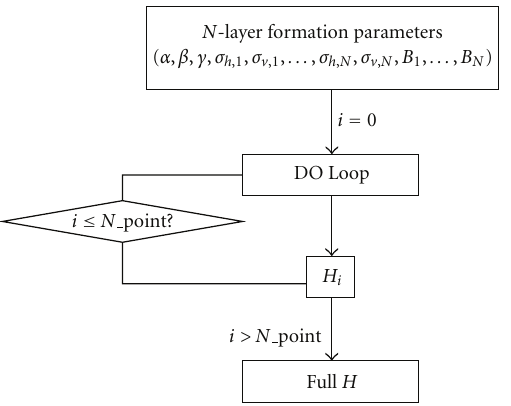
Figure 4: Programming structure of the 1D forward modeling code TRITI2009.